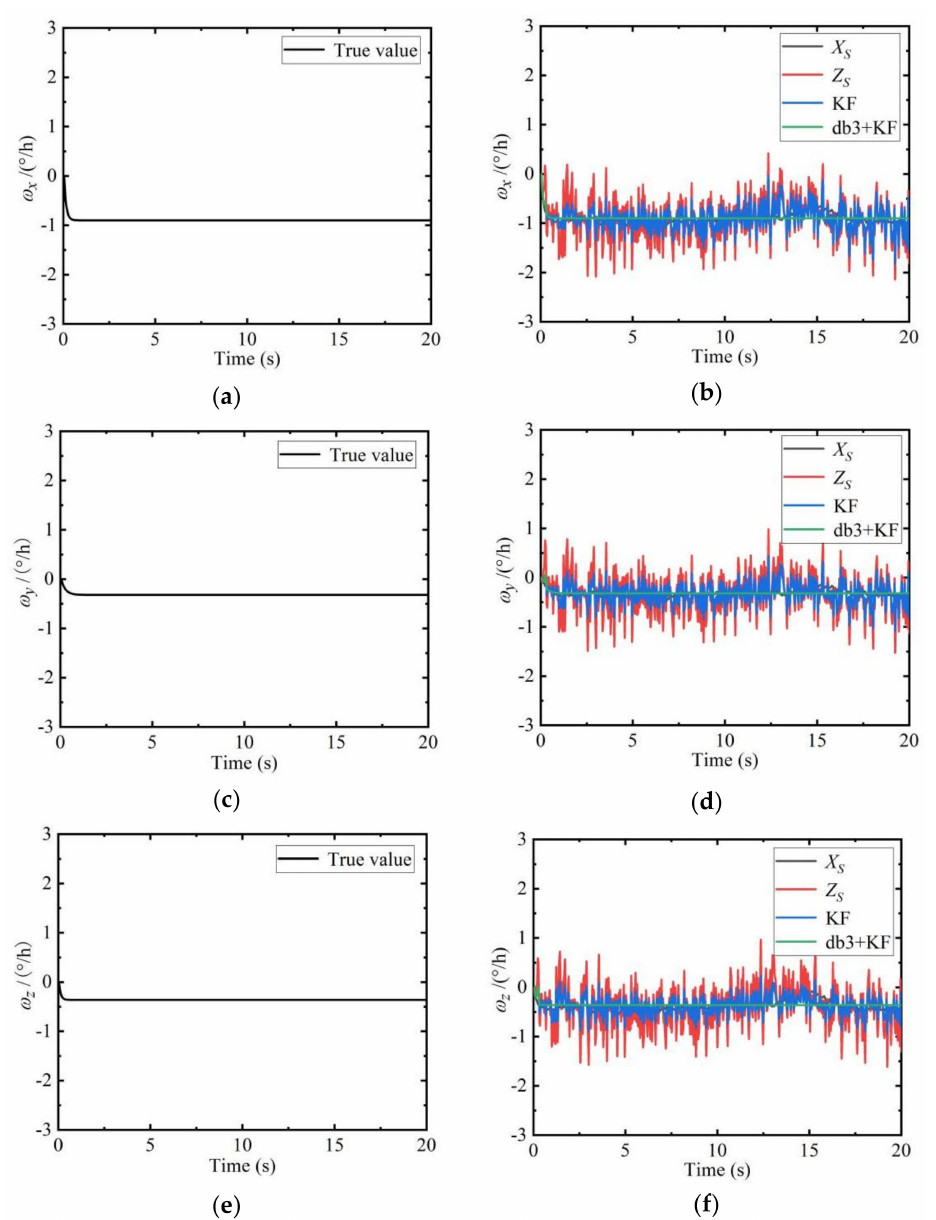
Figure 4. Comparison of angular velocity filtering results of the sub-inertial navigation systems (SINS). ( a ) Noiseless ω x of the SINS; ( b ) Noisy ω x of the SINS; ( c ) Noiseless ω y of the SINS; ( d ) Noiseless ω y of the SINS; ( e ) Noisy ω z of the SINS; ( f ) Noiseless ω z of the